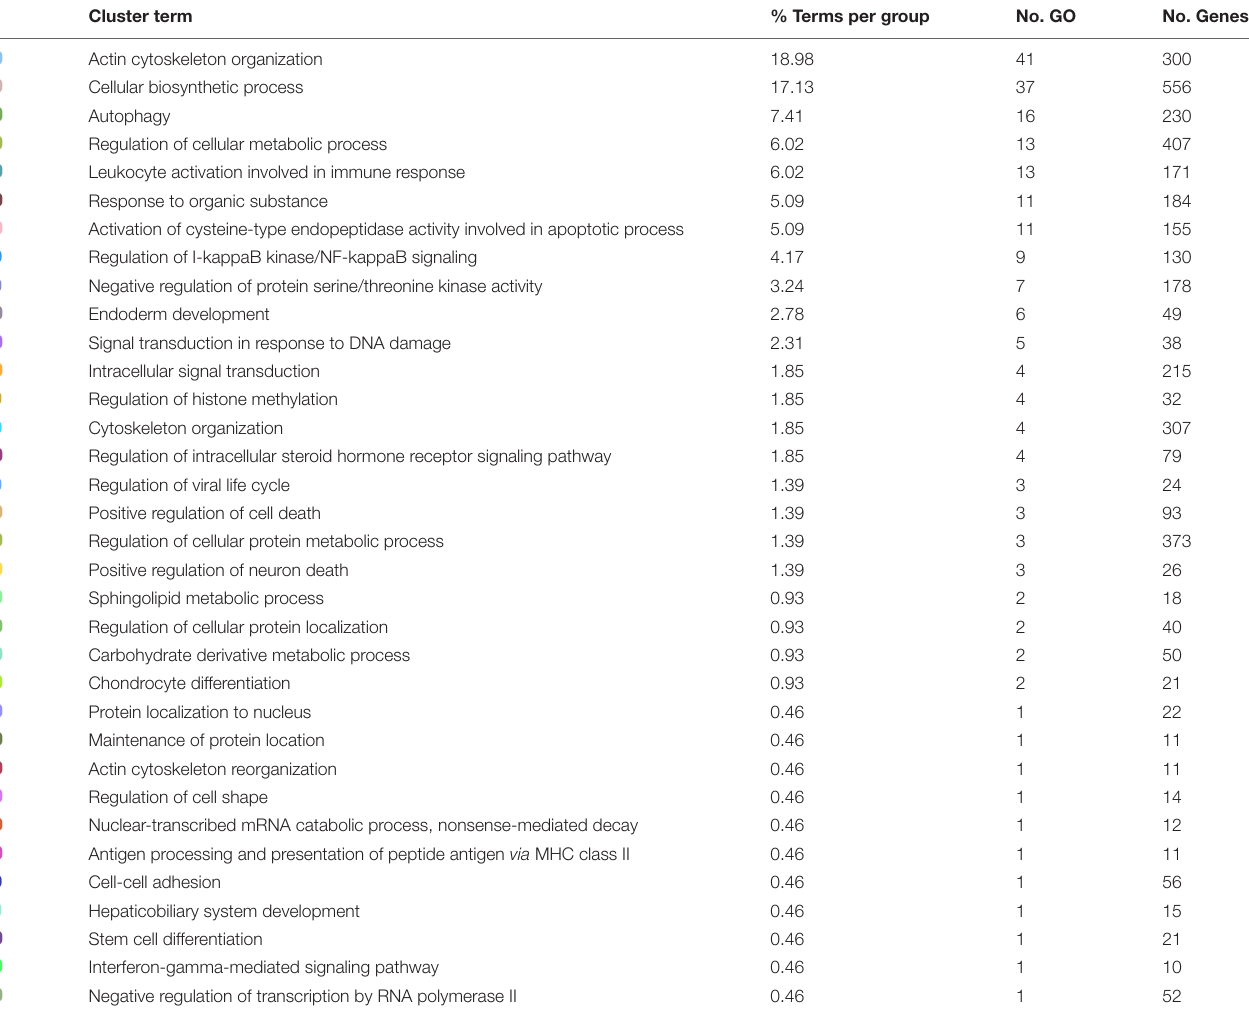
TABLE 2 | List of the 34 total clusters related to representative biological processes identified by the transcripteractome in Atlantic salmon smolts fed the MPLE diet. Cluster term % Terms per group No.